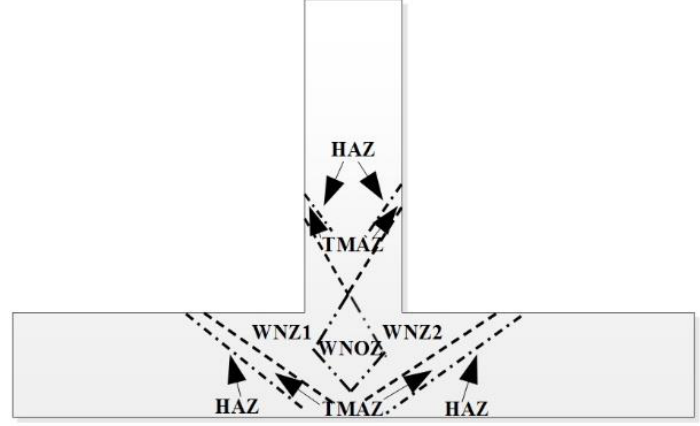
Figure 8. The different zones of the SSFSW T-joint.